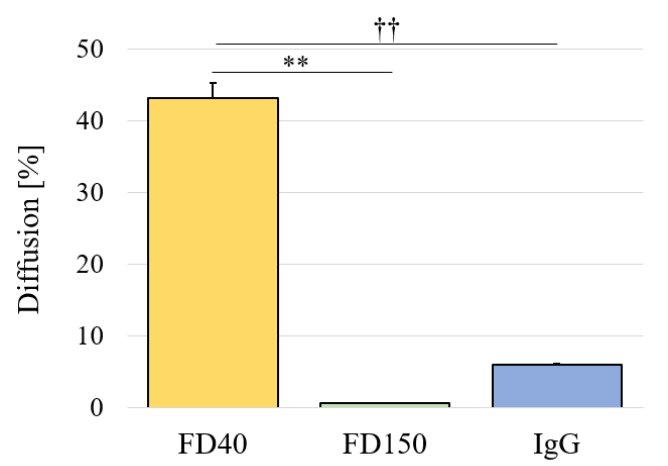
Figure 2. Graph of percentage diffusion of different FITC-conjugated dextran and immunoglobin G (IgG) taken at day 7 (n = 3 for each group). The experiment was conducted in 12-well transwell inserts by replacing the insert’s original PET membrane with a PEGDM membrane (thickness: 100 μm ). Error bar indicates standard deviation; ** and †† indicate p < 0.00005 and p < 0.00001 respectively.